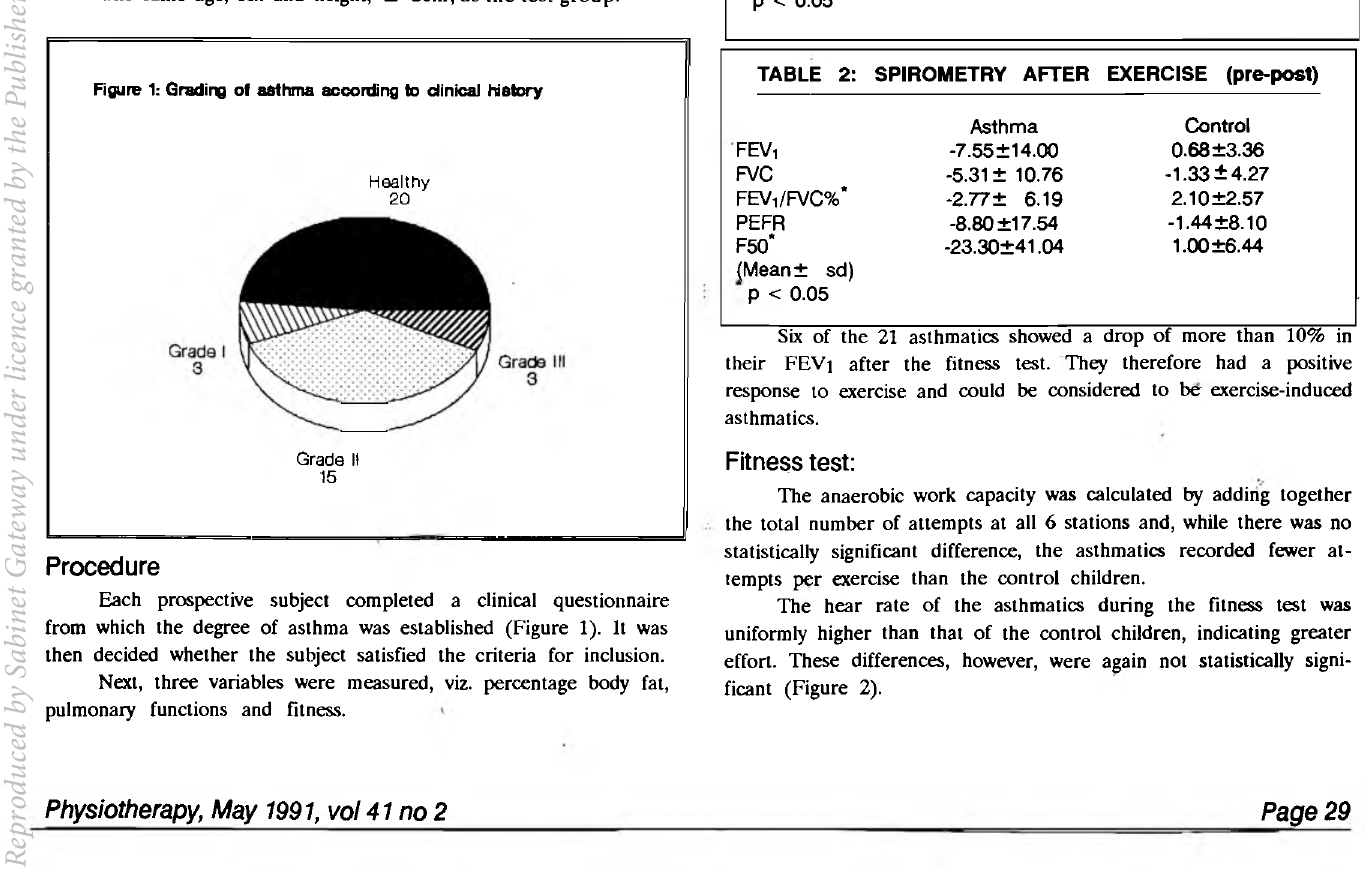
Figure 1: Grading of asthma according to dlnical history